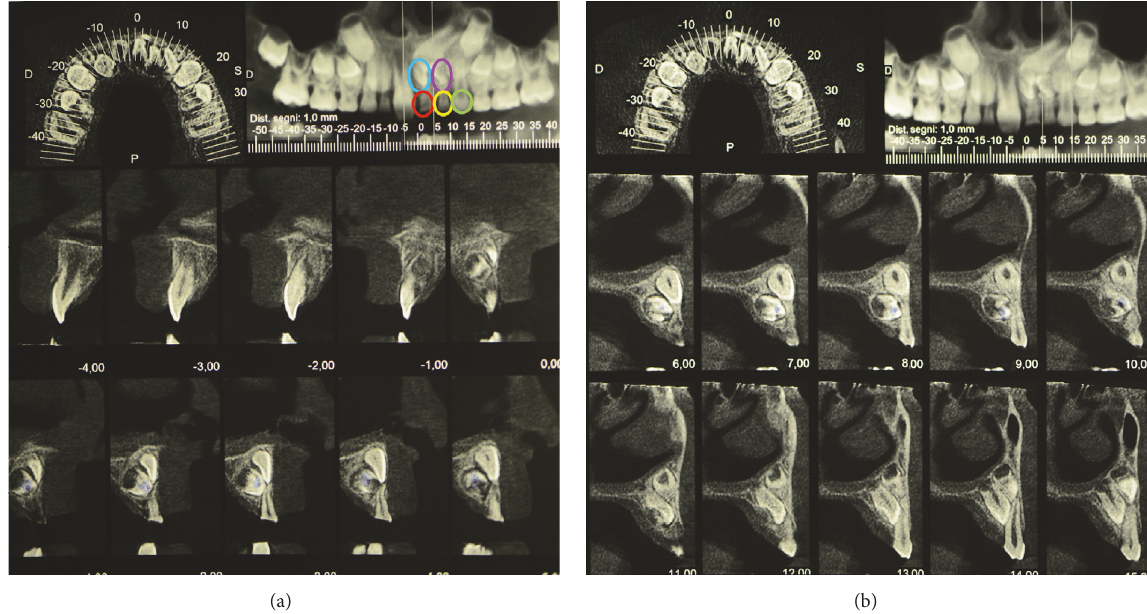
Figure 3: (a) CBCT of the patient showing 3 deciduous teeth (61 in red circle, 62 in yellow circle, and 63 in green circle) and 2 supernumerary teeth (blue and violet circles). (b) CBCT of the patient showing displacement of permanent teeth 21 and 22.